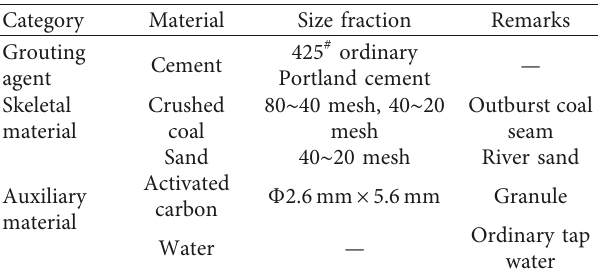
Table 1: Raw materials of similar material for coal and gas outburst similar simulation